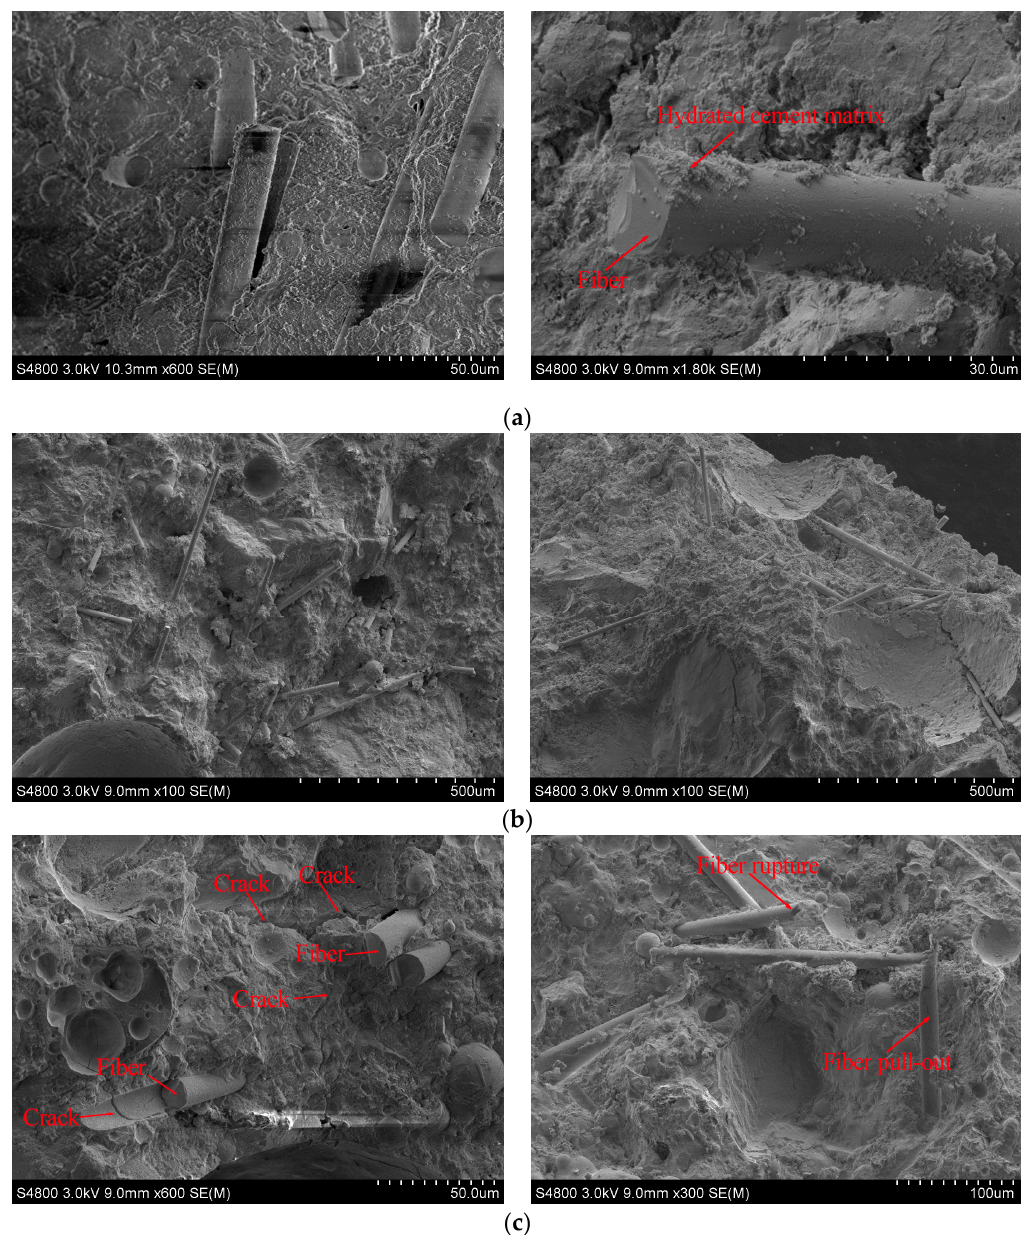
Figure 4. Scanning electron microscope images of BF-ECC. ( a ) SEM photomicrographs of BF reinforced cement paste; ( b ) SEM photomicrographs of BF dispersion; ( c ) SEM photomicrographs of BF damage.